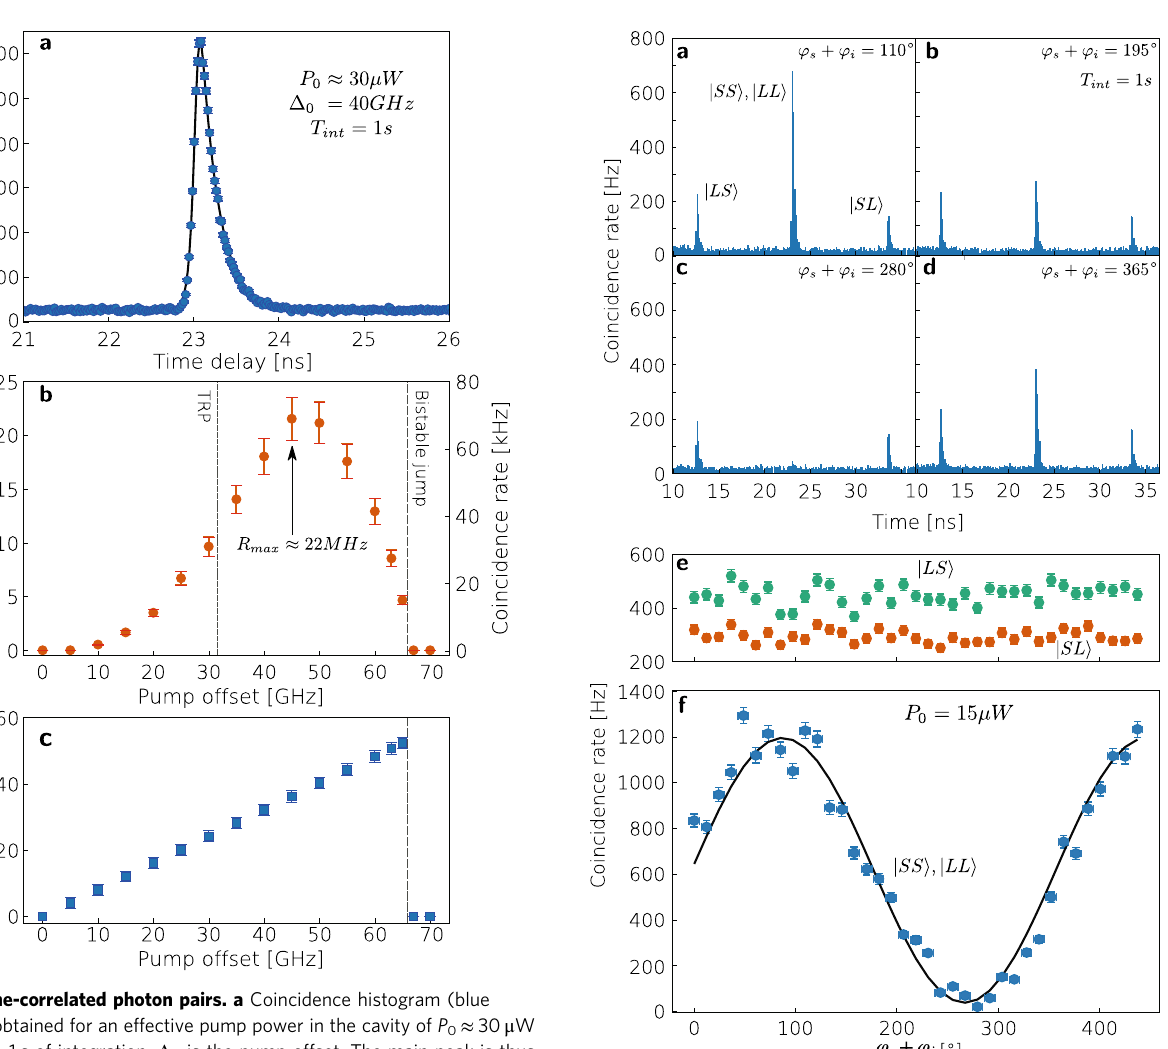
Fig. 3a – d obtained after only 1 s of integration. On the one hand,